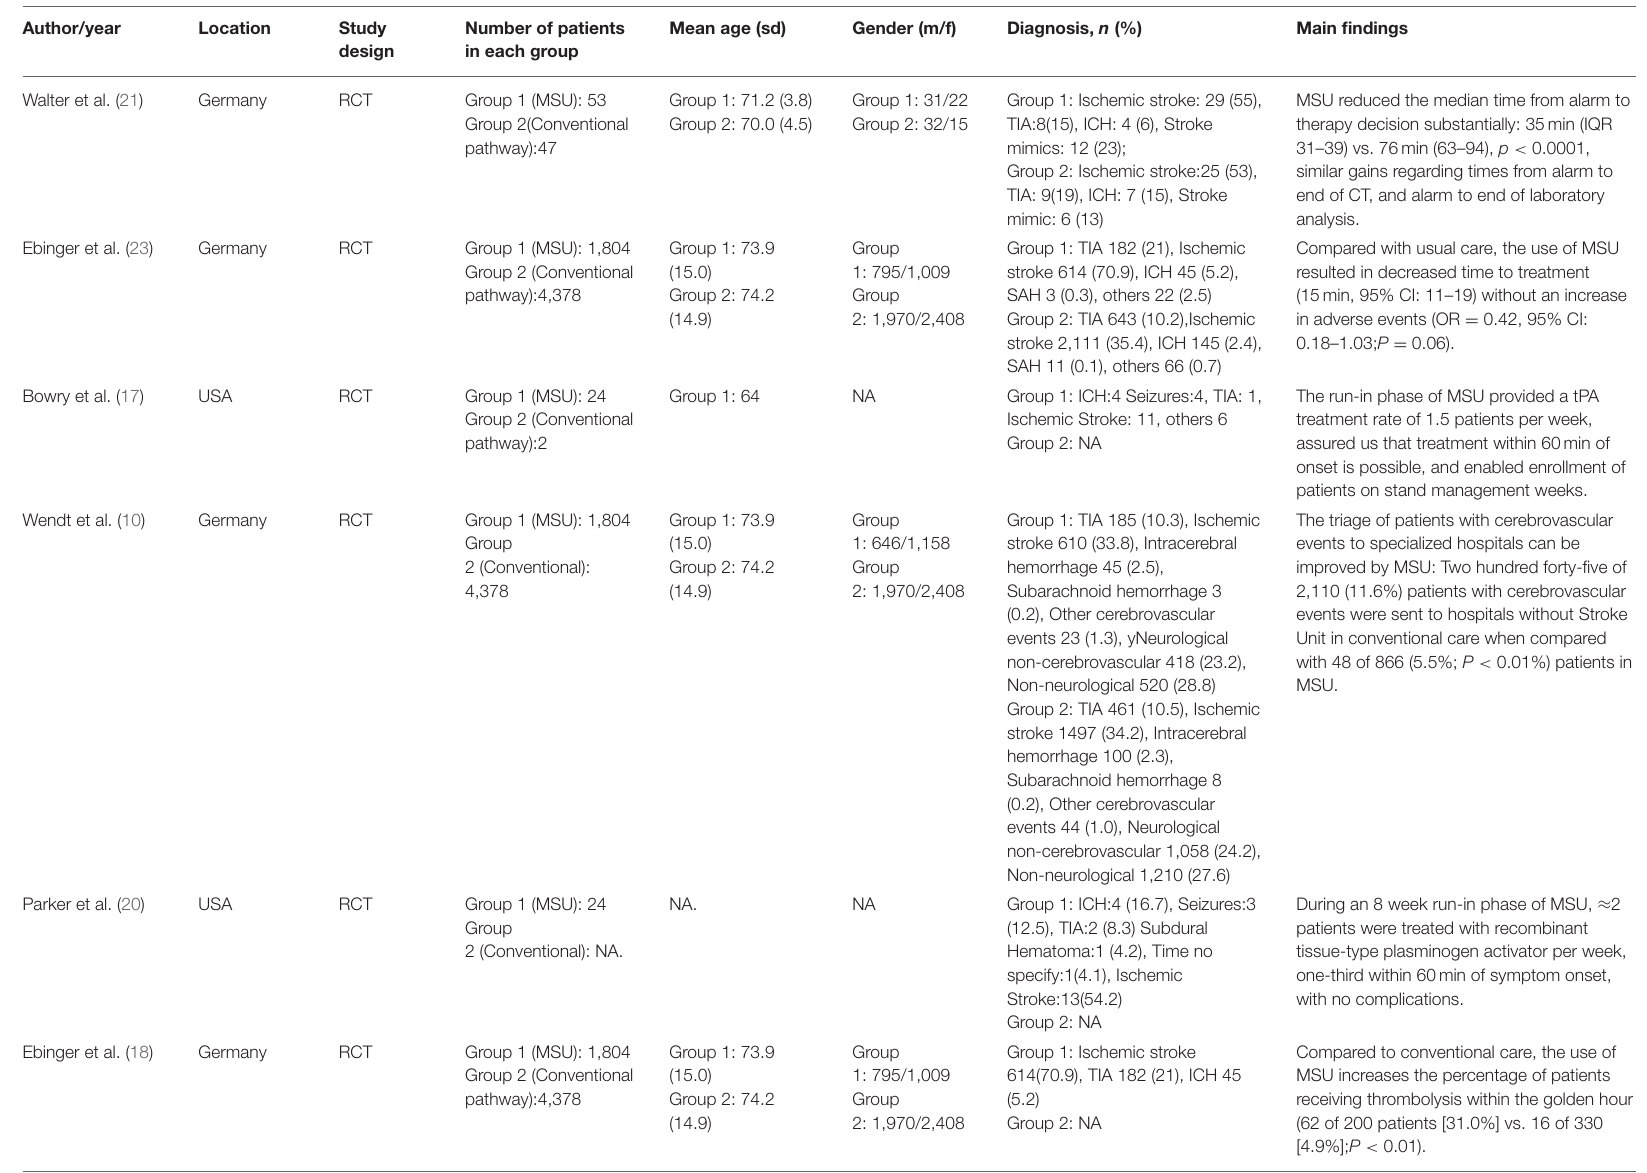
TABLE 1 | The general characteristics of the included RCT and non-RCT